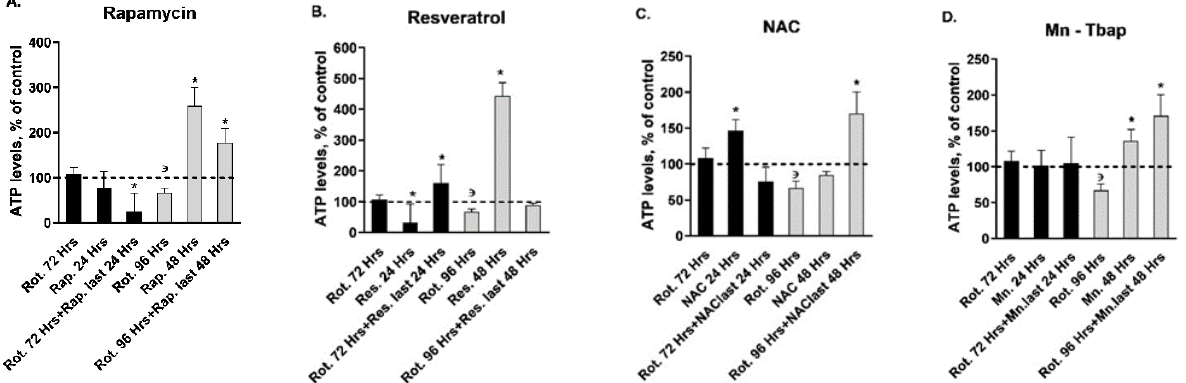
Figure 3. Effect of ROS scavengers/autophagy enhancers on ATP Levels pre and post exposure to 10 pM rotenone